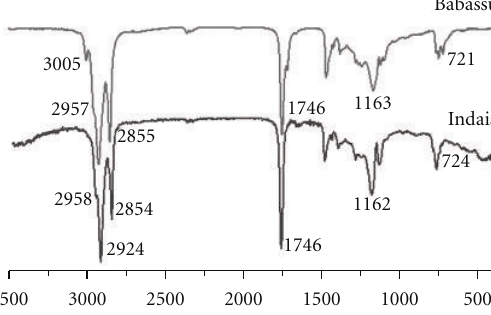
Figure 3: FT-IR spectra of indai´a and babassu oils.